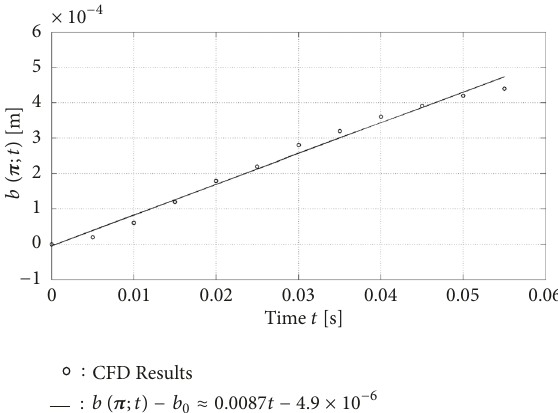
Figure 5: Time evolution of the neck heights 𝑏( 𝜋 ;𝑡) in the viscous regime. The circular markers ∘ indicate the numerical experiment results and the solid line represents the fitted curve.